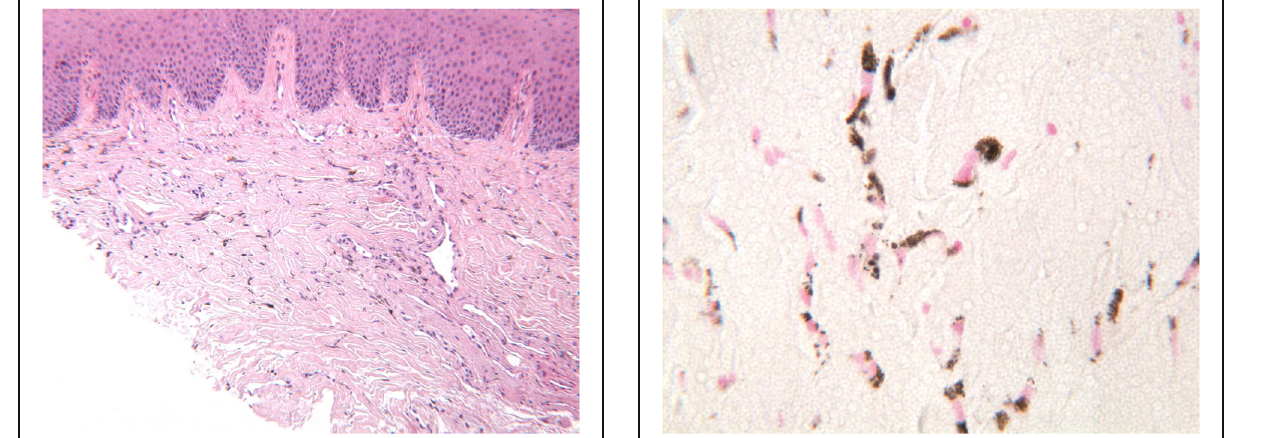
Fig. 2 The lamina propria of the oral mucosa contained brown pigment scattered between collagen fibres and in the cytoplasm of macrophages (H&E ×10)